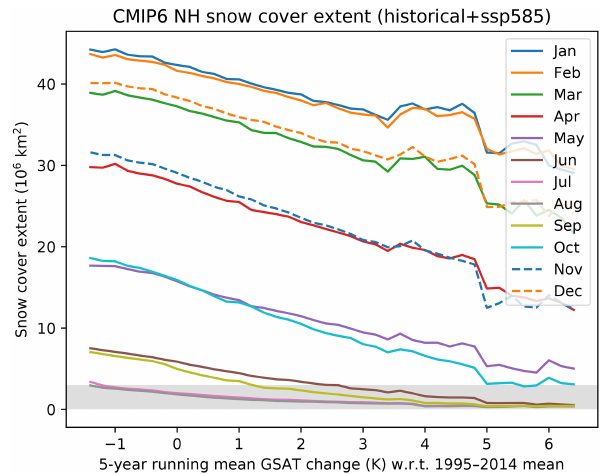
Figure 10. Multi-model mean CMIP6 projected Northern Hemi- sphere snow extent as a function of 5-year mean GSAT for SSP5- 8.5. The shaded region delineates when projected Northern Hemi- sphere snow extent drops below 3millionkm 2 . This threshold is ap- proximately the same fraction of the maximum snow extent as the corresponding fraction used to define the Arctic Ocean as